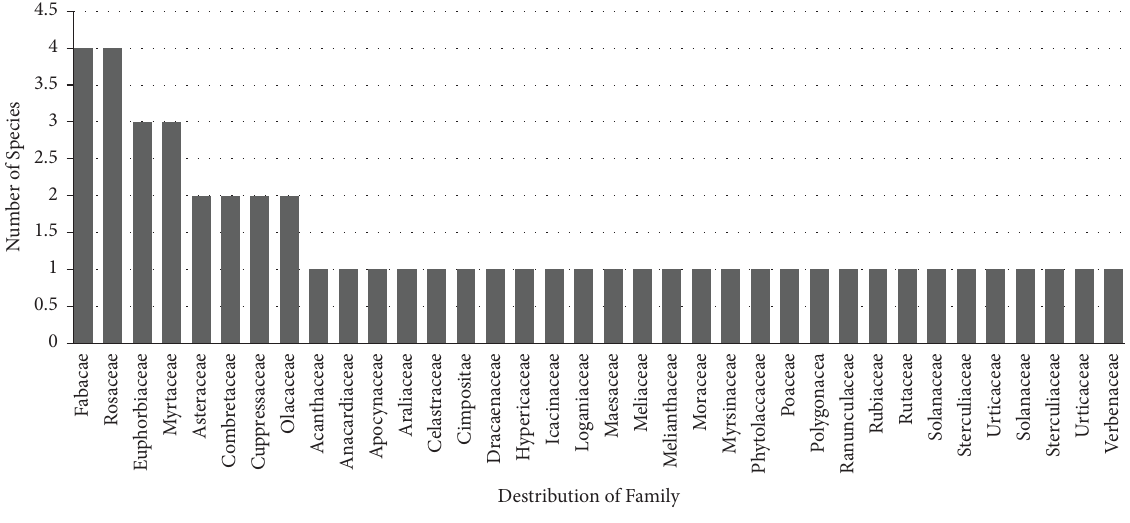
Figure 3: Species distribution per family.